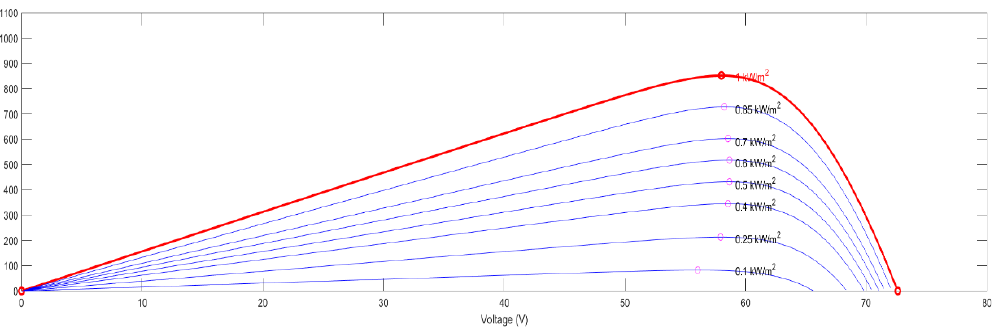
Figure 13. Power curve simulation of the selected panel in different